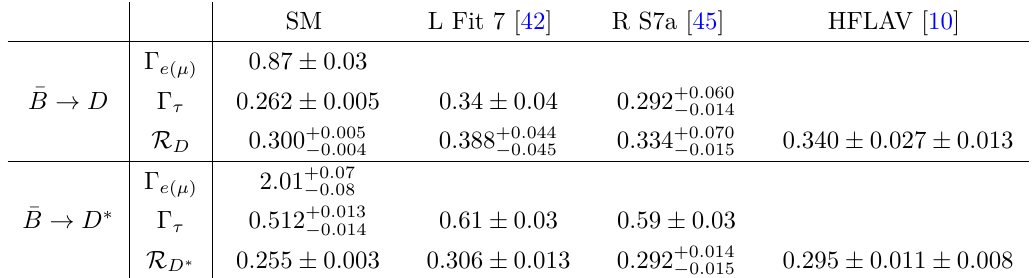
SM L Fit 7 [42] R S7a [45] HFLAV [10]